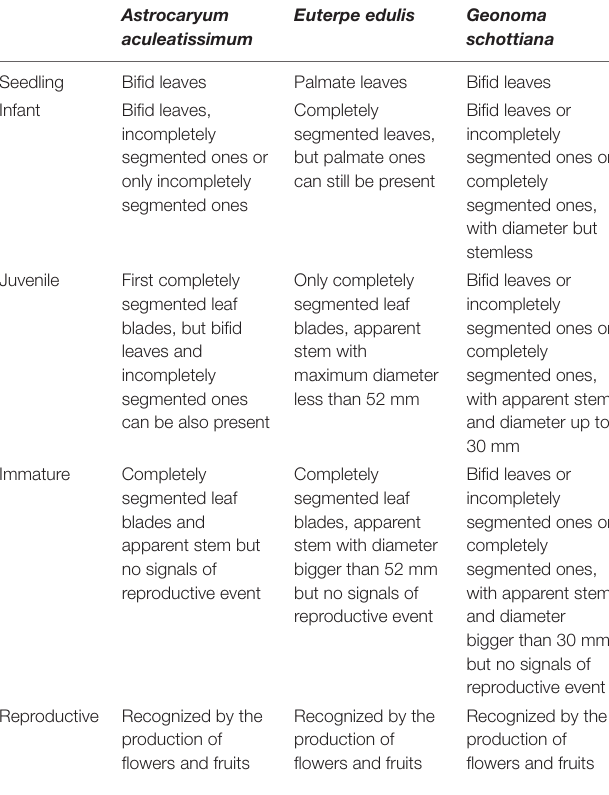
TABLE 1 | Characteristics, based on morphological and morphometrical analysis, of the five ontogenetic stages for Astrocaryum aculeatissimum , Euterpe edulis